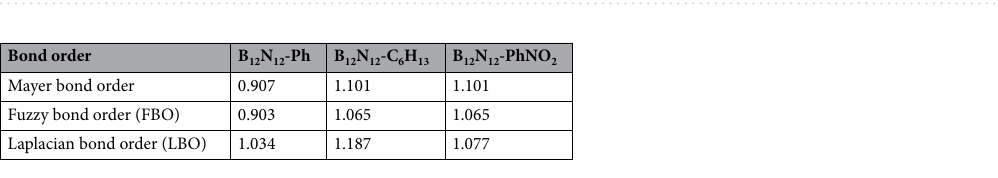
Figure 8. ELF plot of the binding B atom of the B 12 N 12 nanocage and the C atom of the corresponding aryl or alkyl radical.